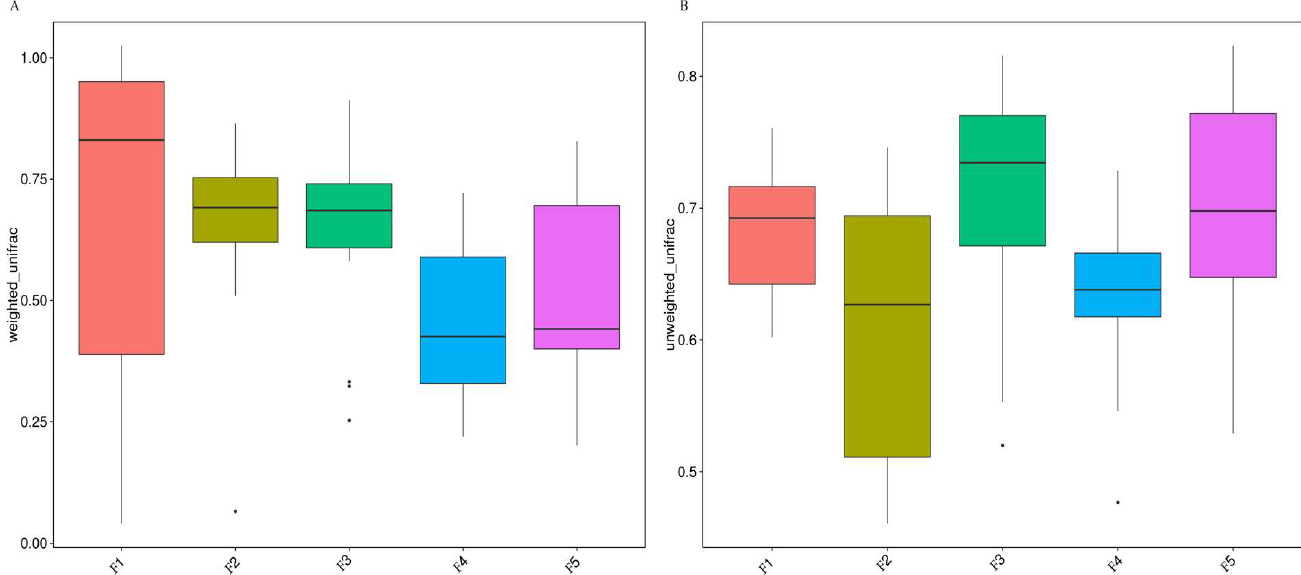
Figure 5. Comparisons for beta-diversity between five wild flocks based on the weighted ( A ) and unweighted ( B ) unifrac distance. The abscissa is the group size, and the ordinate is the unweighted or weighted unifrac distance.